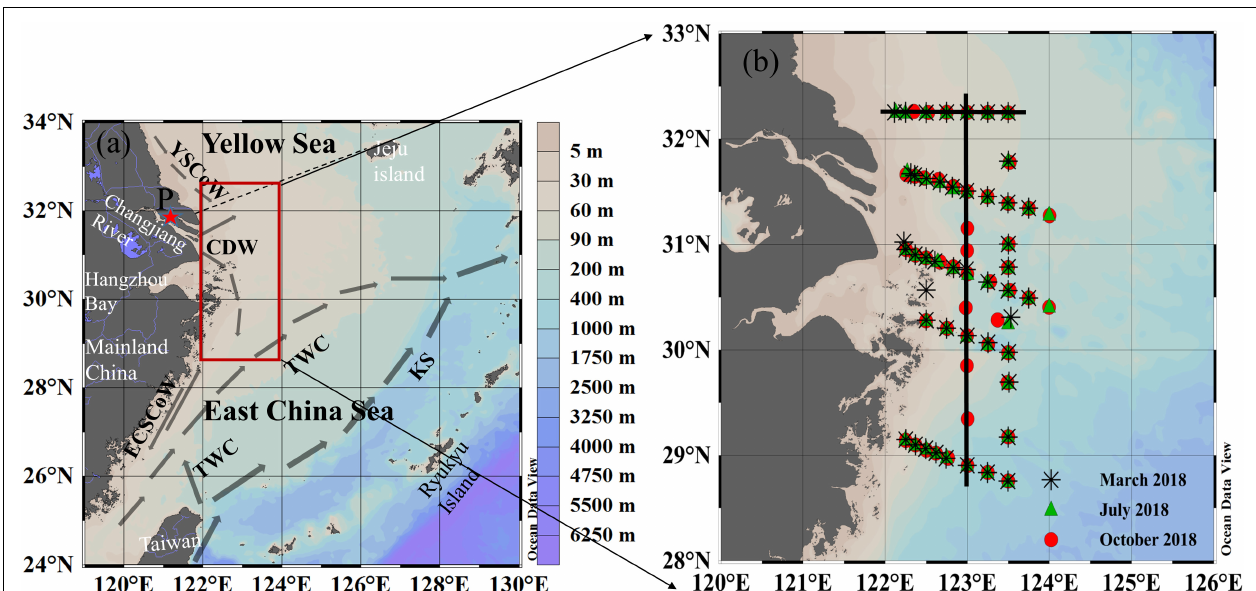
FIGURE 1 | (a) Schematic map of the bathymetry and current system of the ECS, (b) maps of sampling stations in March, July, and October, 2018. In panel (a) , the framed region indicates the area under study. The thin line from the northern corner of the Changjiang estuary to Jeju Island is the traditional boundary between the YS and the ECS. Dark gray arrow sketches major currents in the ECS (Chen, 2009), including the Kuroshio (KS), the Taiwan Warm Current (TWC), the East China Sea Coastal Water (ECSCoW), the Changjiang Diluted Water (CDW), and the Yellow Sea Coastal Water (YSCoW). The station P (red star, 121.10 ◦ E, 31.75 ◦ N) was used to represent the freshwater end-member for deriving the PO 43 − hypothetical mixing line between the freshwater and seawater end-member of the CDW. The direct lines in (b) are transects 32 ◦ N and 123 ◦